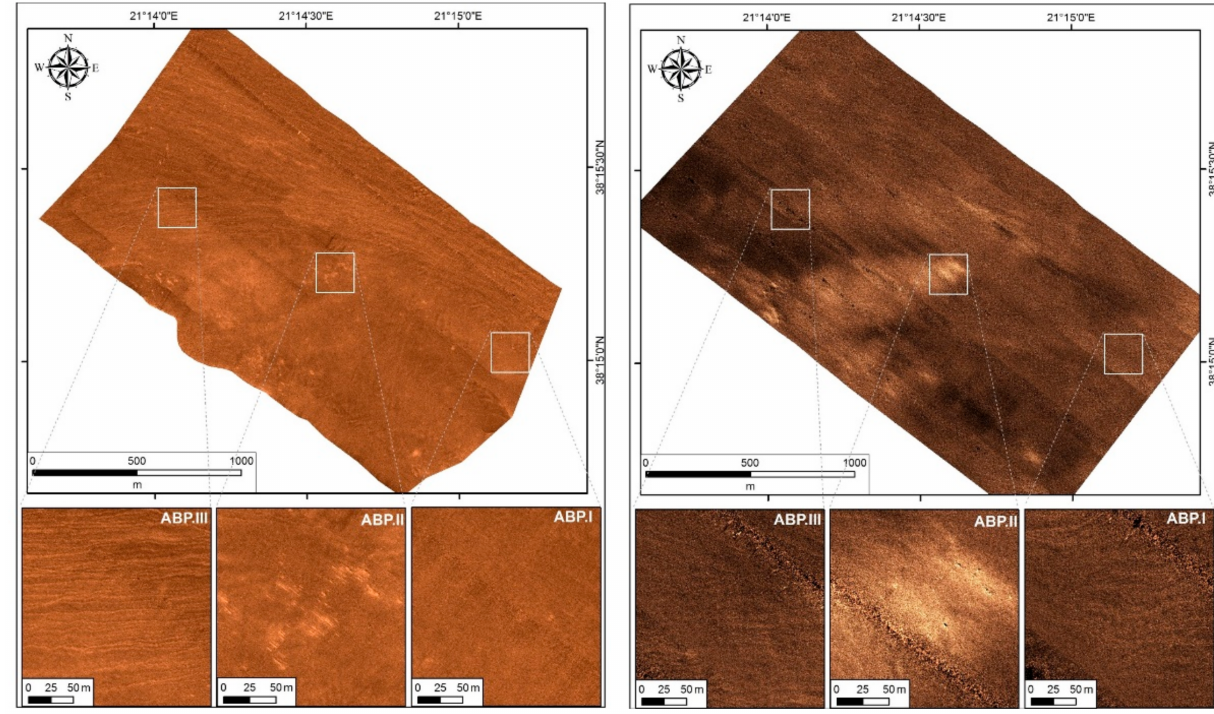
Figure 4. Side-scan sonar mosaics at 100 kHz ( left ) and 400 kHz ( right ) of the “small target” area and representative sonographs of the three acoustic backscatter